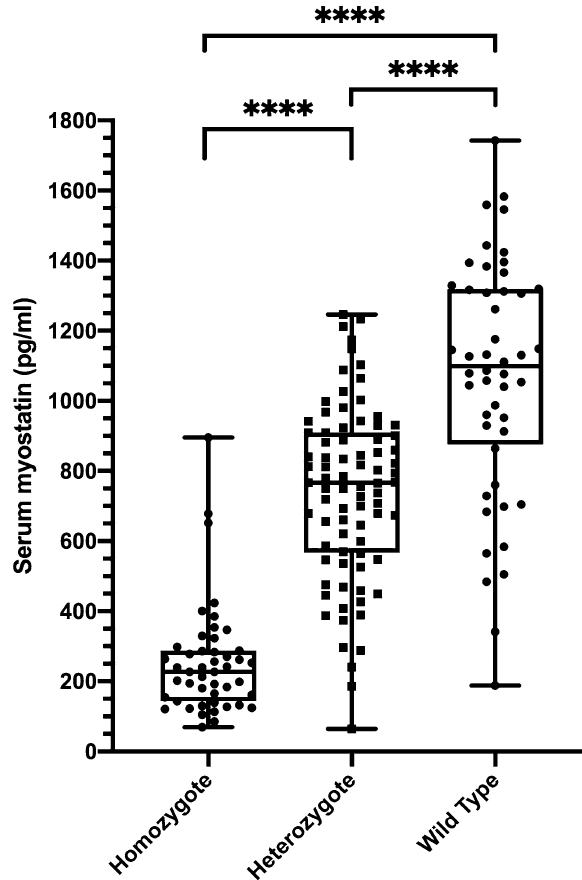
Figure 2. Comparison of serum myostatin concentrations between Thoroughbred horses of different MSTN genotypes. Note that homozygotes (n = 47) have significantly lower (but still detectable) serum myostatin concentrations than heterozygotes (n = 81) which in turn have lower concentrations than wild type horses (n = 48). There is substantial overlap in serum myostatin concentrations, particularly between heterozygotes and wild type horses. Individual data points shown and boxes represent the median and interquartile ranges and whiskers the range. (****P <